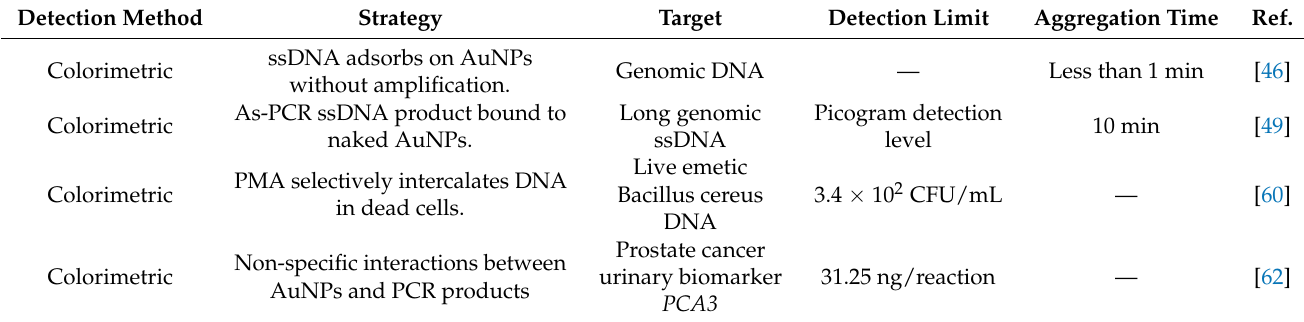
Table 1. Comparison of non-specific combinations of AuNPs with conventional PCR